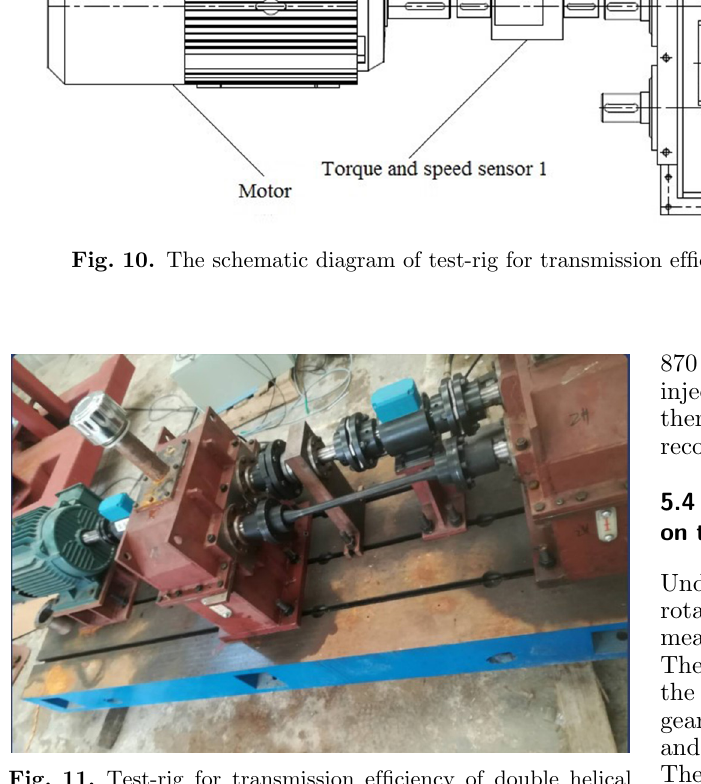
Fig. 11. Test-rig for transmission ef fi ciency of double helical gears with closed power fl